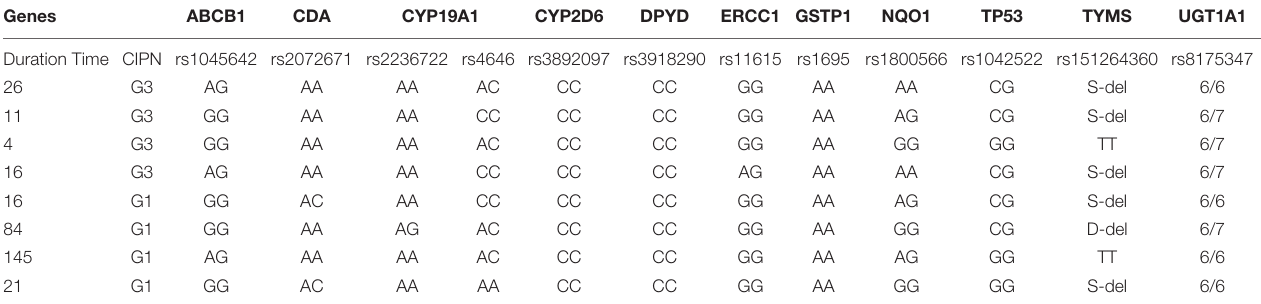
del: del/del; S-del:TTAAAG/del; TT: TTAAAG/TTAAAG; 66: (TA)6/(TA)6; and